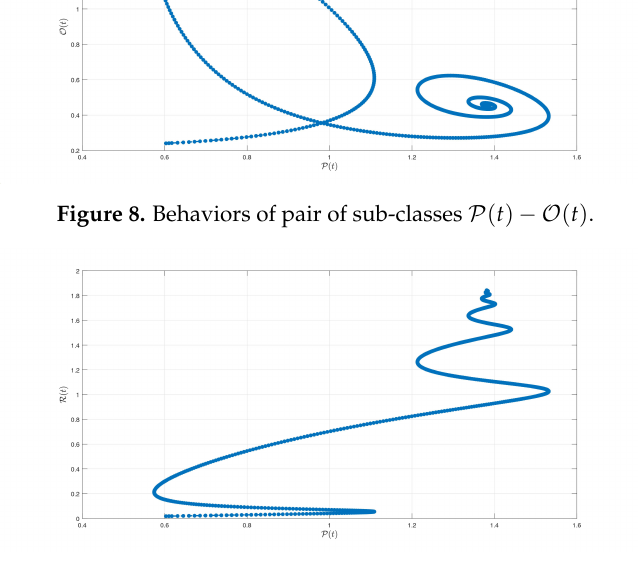
Figure 9. Behaviors of pair of sub-classes P ( t ) − R ( t ) .